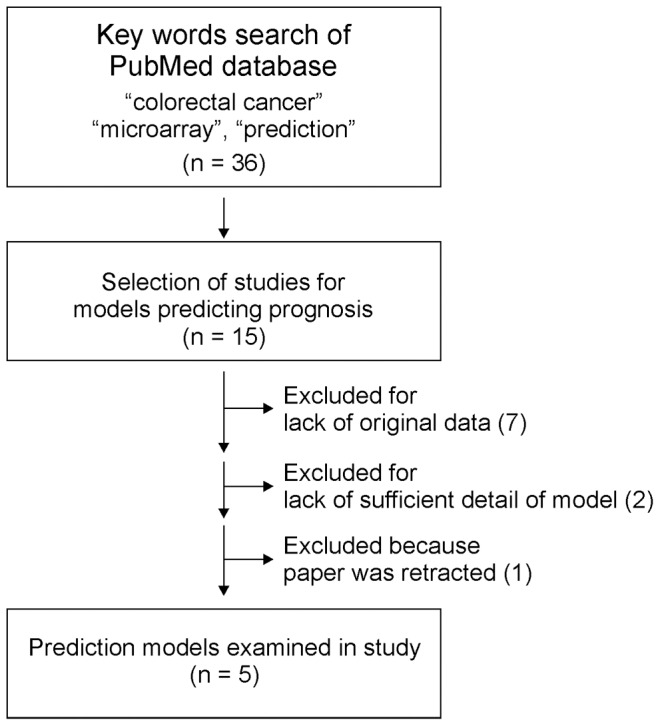
CONSORT flow diagram for selection of prediction models.